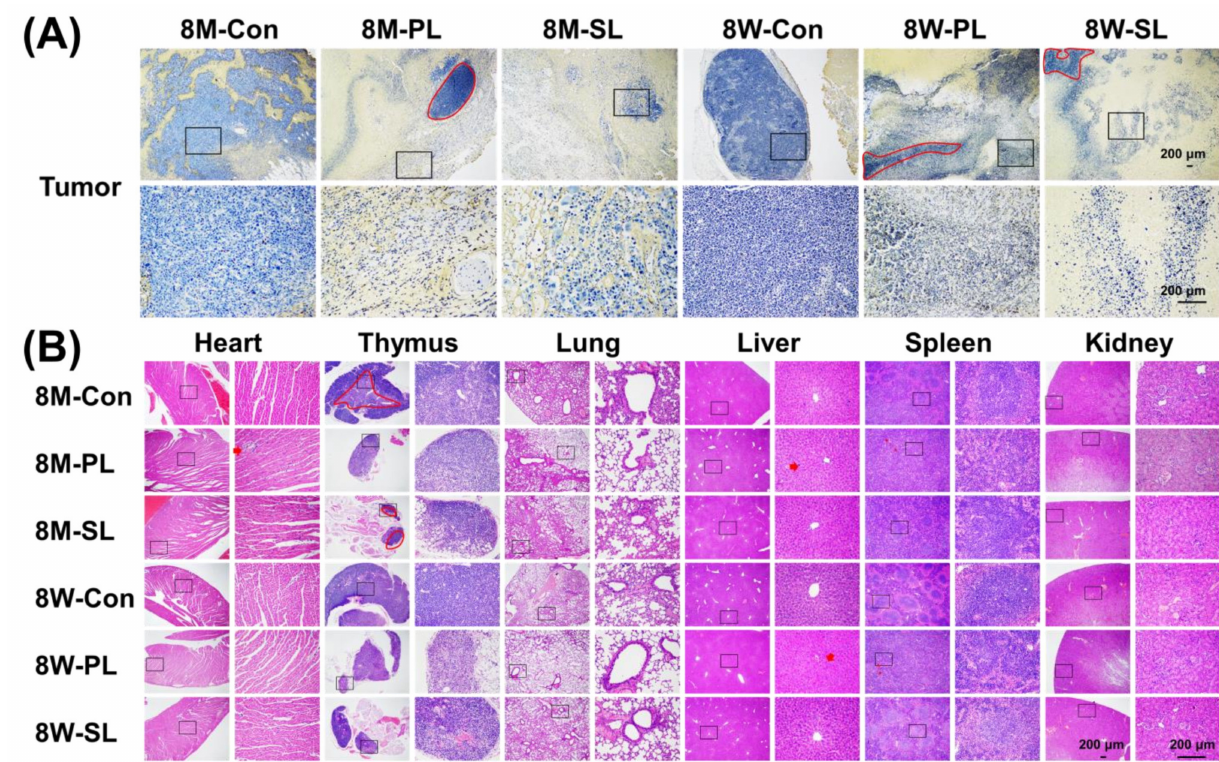
Figure 7. ( A ) The distribution of live and apoptotic cells in tumors of different-aged mice by using TUNEL (40 × , 200 × ). ( B ) The degree of damage to heart, thymus, lung, liver, spleen, and kidney sections of different-aged mice using hematoxylin and eosin (H&E). The red marks indicate abnormal cell states (40 × , 200 ×